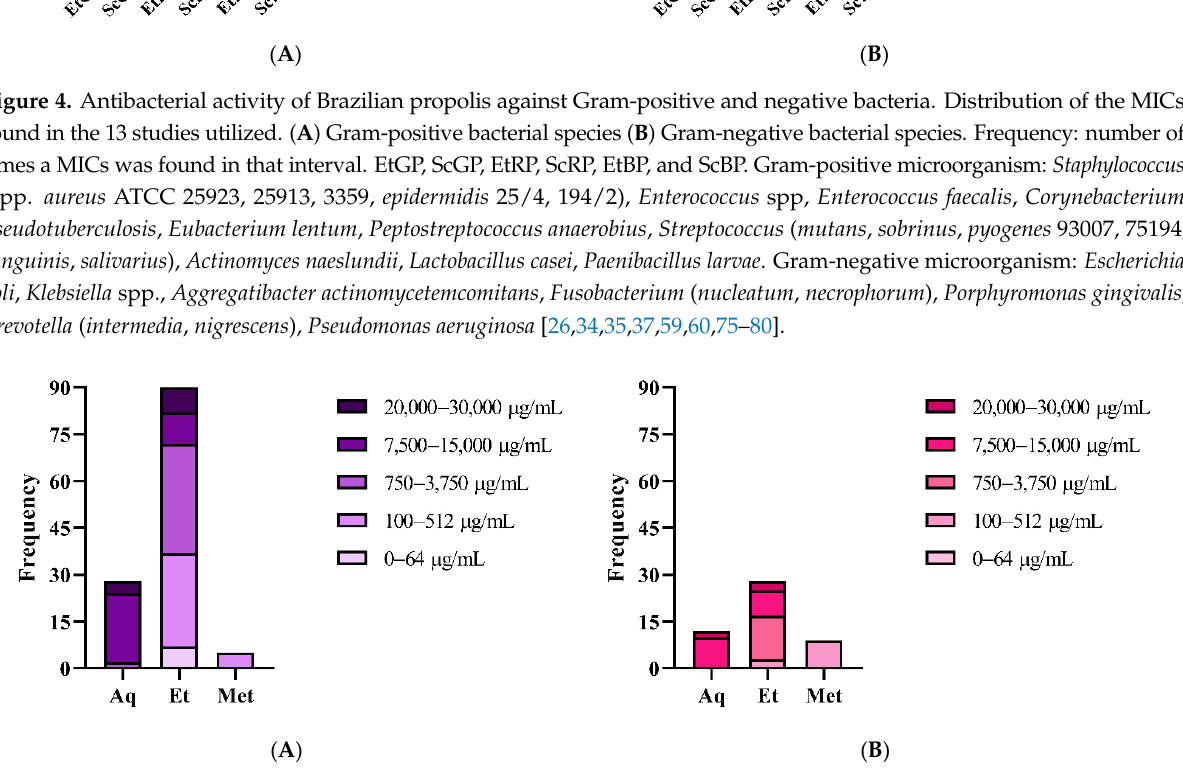
Figure 5. Antibacterial activity of Mexican Propolis against Gram-positive and negative bacteria. Distribution of the Minimal Inhibitory Concentrations (MICs) found in the 13 studies utilized. Frequency: number of MICs found in that interval. ( A ) Gram-positive bacterial species ( B ) Gram-negative bacterial species. Et, Aq, and Met extract of propolis. Gram-positive microorganism: Staphylococcus ( aureus , epidermidis ), Streptococcus ( mutans , oralis , sanguinis , pyogenes , agalactiae ), Listeria ( monocytogenes , innocua ), Mycobacterium tuberculosis , Salmonella typhi [29,40,41,56,81–87]. Gram-negative microorganism: Porphyromonas gingivalis , E. coli , Klebsiella pneumoniae , Vibrio ( cholerae , alginolyticus , vulnificus ), Pseudomonas aeruginosa [81–86,88].